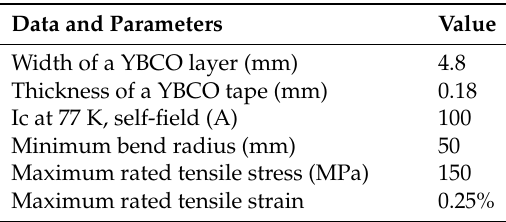
Table 2. Specification parameters of